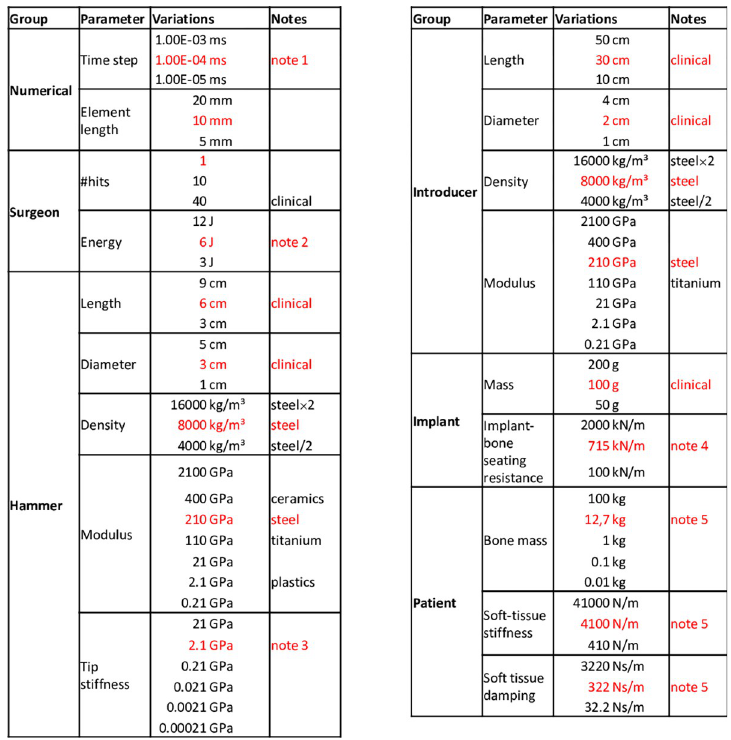
Fig 2. Nominal values for each parameter (red) and their variations. Note1: This value results in 1000 points representing the nominal applied force-time impaction impulse; Note2 from [17]; Note3: This value results in a clinically measured impaction force [16]. Videos of the load transfer for the varied hammer-introducer stiffness (nominal, +/-order of magnitude) can be found as S1–S3 Files; Note4: Data for porous-coated stem in cadaveric femur [27]; Note5: from